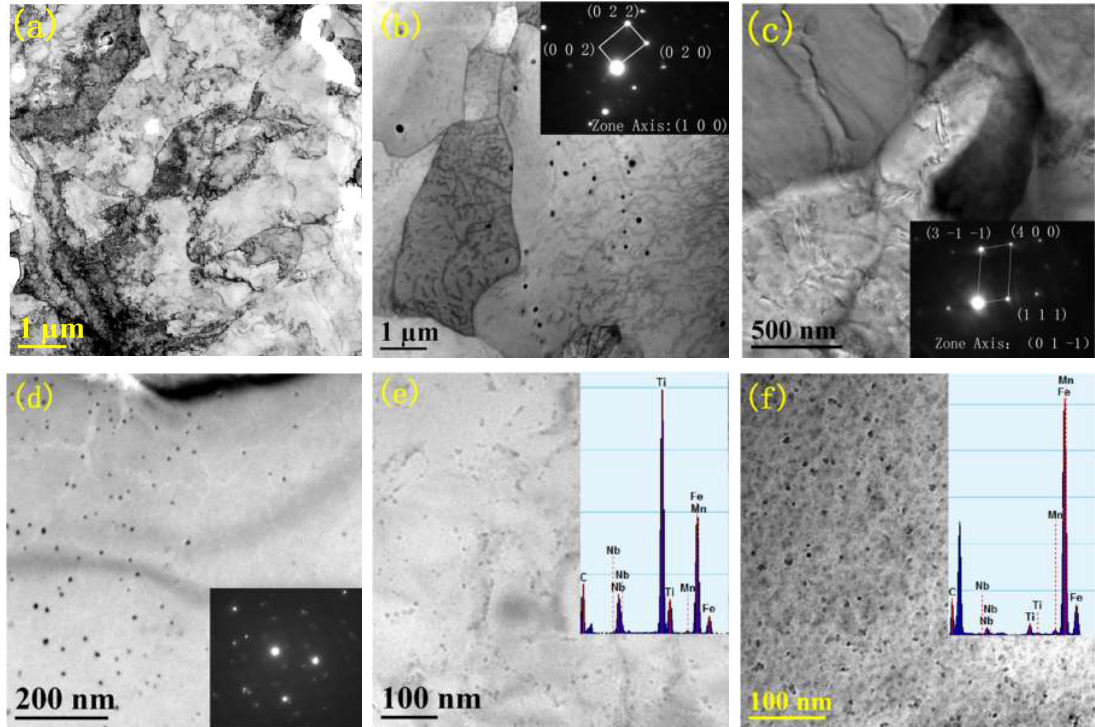
Figure 4. TEM images during tempering at di ff erent temperatures. ( a ) TEM image before tempering; ( b )TEM image at 200 ◦ C—precipitation of cementite I; ( c ) TEM image at 300 ◦ C—decomposition of retained austenite; ( d ) TEM image at 300 ◦ C—precipitation of cementite II; ( e ) TEM image at 550 ◦ C—alloy carbide precipitation; ( f ) TEM image at 650 ◦ C—Mn